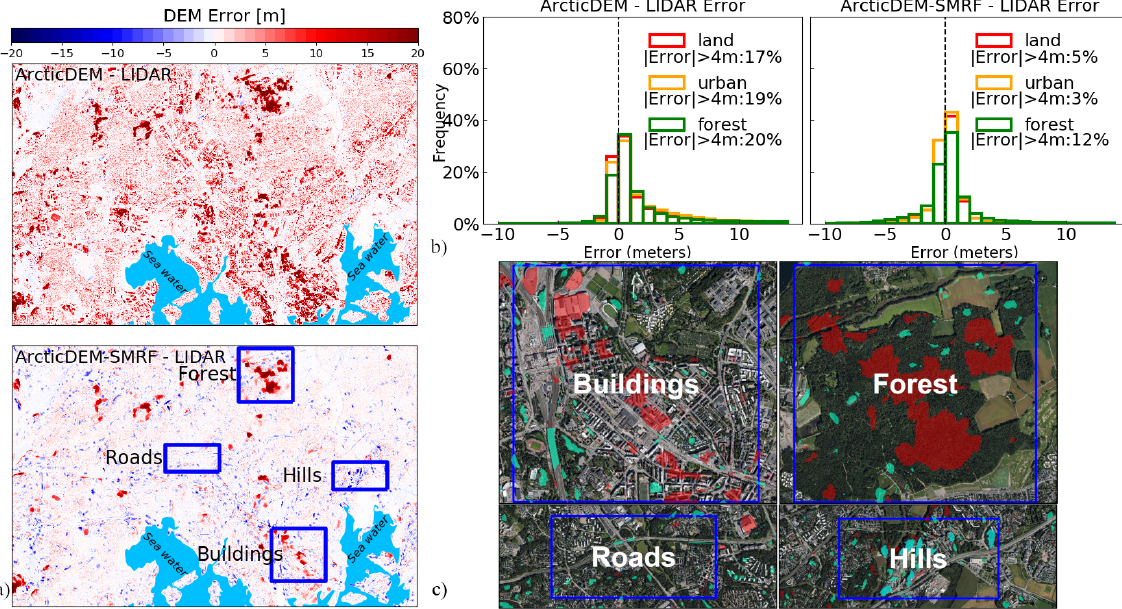
Figure 5. (a) Difference maps between the original ArcticDEM, the optimal ArcticDEM-SMRF (with slope threshold = 0.07, window size = 30m as the SMRF parameters), and the lidar DTM at 2m. (b) The error histograms of the original ArcticDEM and the optimal ArcticDEM-SMRF, where the calculation was conducted at 2m pixel level. In the bottom map of (a) , example locations of four features that relate to the residual errors in the ArcticDEM-SMRF are labelled. The aerial image of these locations is shown in (c) , where areas with errors exceeding 4m are marked ( > + 4m as red polygons and < − 4m as green polygons, polygons are in 50% transparency). The aerial image is an orthophotograph of Helsinki with a horizontal resolution of 8cm, acquired during the growing season of 2017, which was accessed from Helsinki Region Infoshare at https://hri.fi/data/en_GB/dataset/helsingin-ortoilmakuvat (last access: 26 January